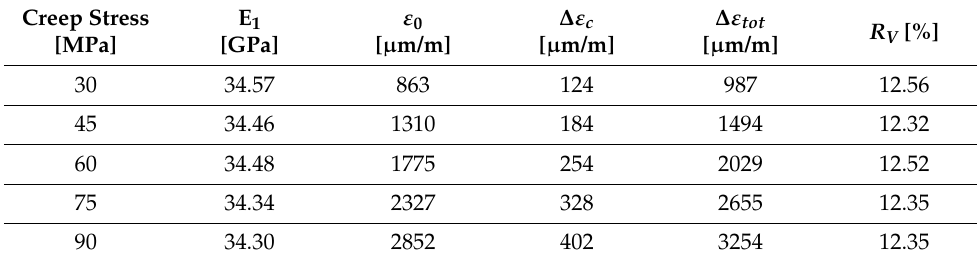
Figure 15. Creep-recovery tests analysis: ( a ) compliance curves of the creep phases; ( b ) isochronous curves.